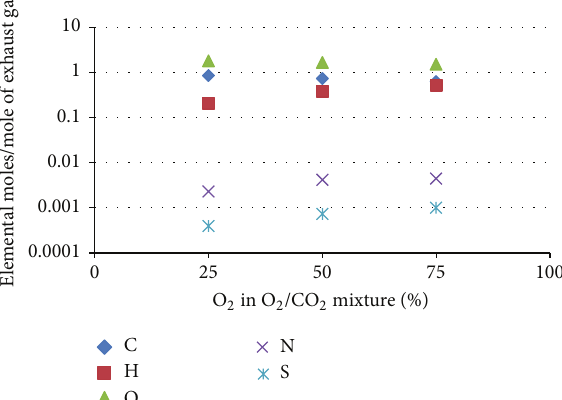
Figure 6: Effect of O 2 percentage in oxidant mixture on outlet gas composition (CFD